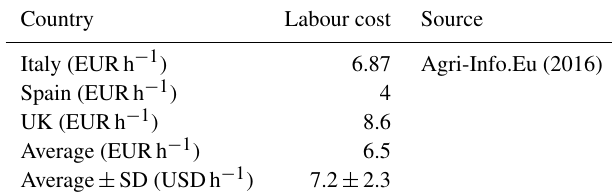
Table D1. Labour cost per hour, in European agriculture for selected countries.